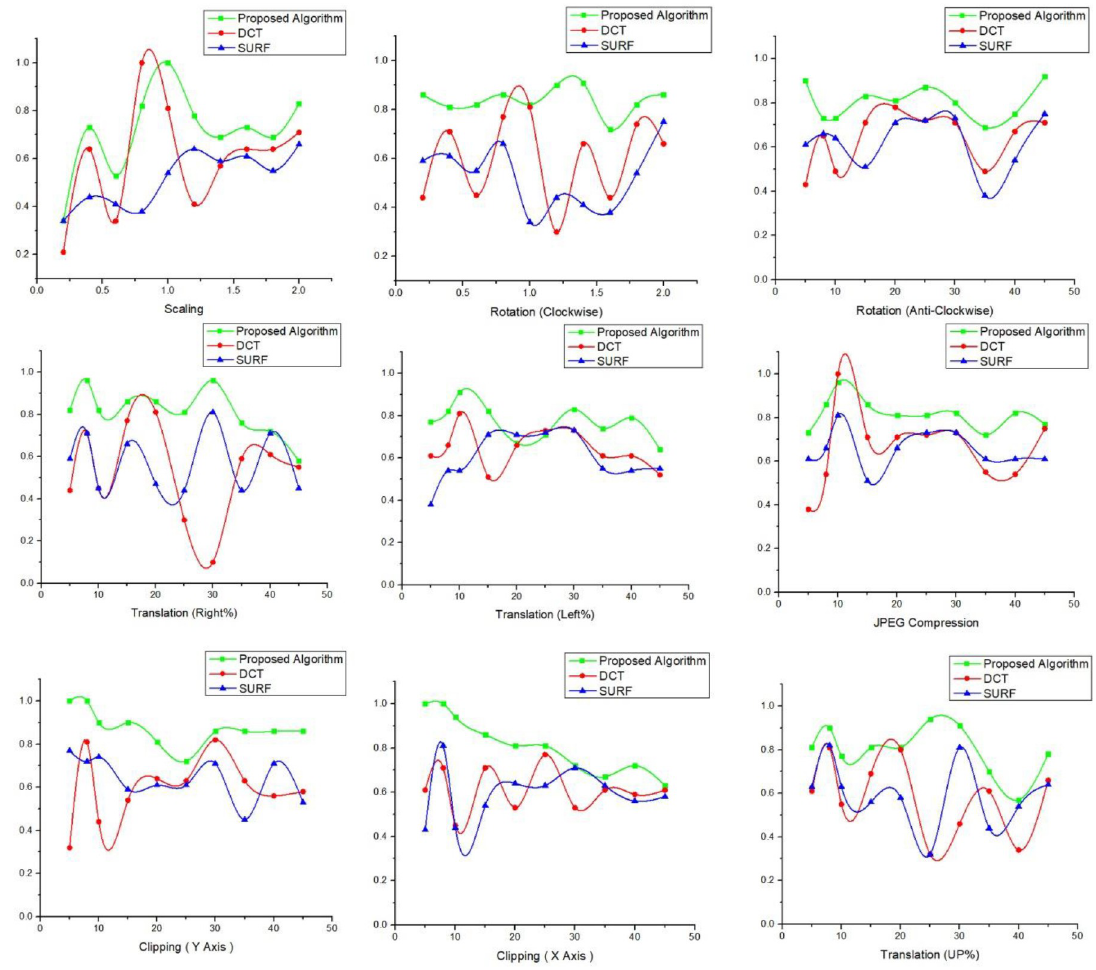
Fig 14. Comparison of proposed algorithm with DCT and SURF on different values of attacks with correlation